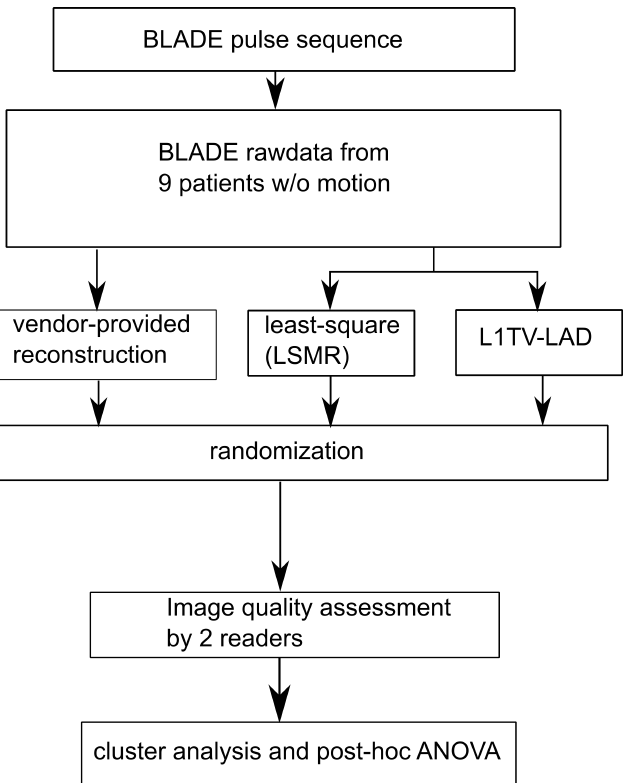
Figure 1. Experimental design in the study. 9 patients were scanned by the BLADE protocol. Images were generated by vendor-provided reconstruction (the sampling density compensation), the least- squares method (using LSMR) and L1TV-LAD. Images were randomized for blinded image quality assessment by 2 readers. The results were statistically analyzed by cluster analysis with repeated measures